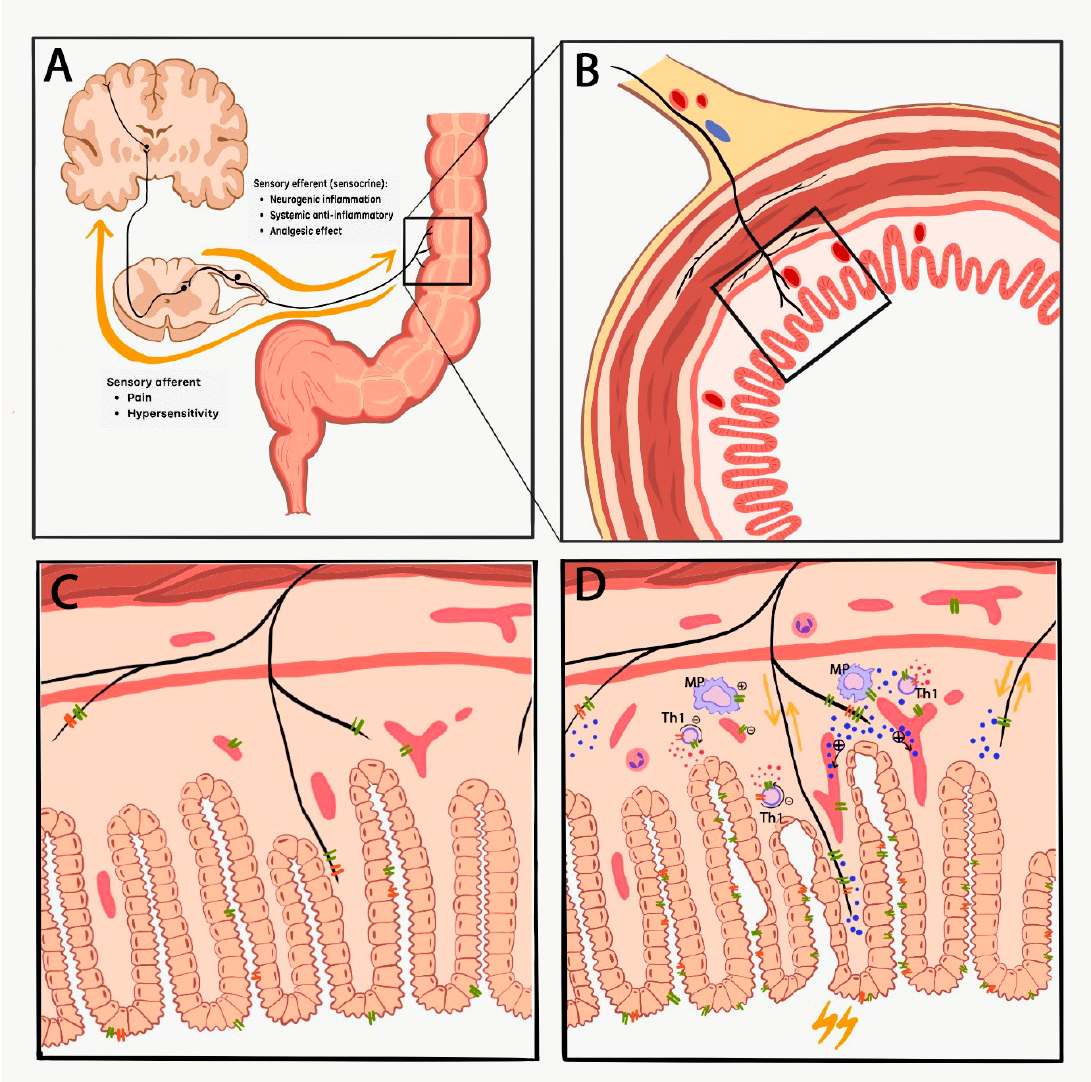
Figure 1. The complex interactions of TRPV1 and TRPA1 and their virtually contradictory role in colitis. Panel A demonstrates the afferent and efferent (sensocrine) functions (yellow arrows) of the capsaicin-sensitive sensory nerve fibers. Panel C (without inflammation) and D (during inflammation) depict an enlarged schematic section of the colon cross section (panel B) focusing on the expression and interaction of TRPV1 (green double lines) and TRPA1 (orange double lines) in the colon mucosa. Neurogenic inflammation is mediated via the release of SP and CGRP (blue dots represent neurotransmitters, such as SP, CGRP and somatostatin), resulting in increased vascular permeability, plasma protein extravasation and inflammatory cell activation. Meanwhile, anti-inflammatory sensory neuropeptides, such as somatostatin and opioid peptides released simultaneously from the same nerve ending exert anti-inflammatory and analgesic actions both locally and systemically through getting into the circulation. Furthermore, these ion channels on vascular smooth muscle and inflammatory cell such as macrophages (MP) and T helper cells (Th1) mediate both pro- (+) and anti-inflammatory (-) effects by regulating the release of cytokines (IFN- γ , IL-2, IL-10, TNF α are represented as red dots).